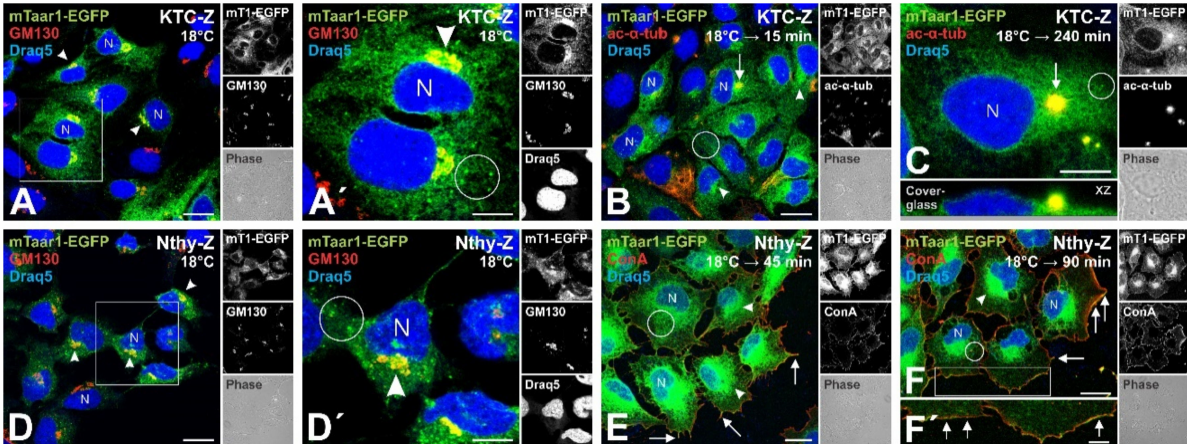
Figure 5. Pulse-chase experiment shows Taar1-EGFP transport along the secretory pathway to procilia of KTC-Z cells. ( A , A’ , D , D’ ) mTaar1-EGFP is localized in the Golgi (arrowheads) in KTC-Z and Nthy-Z cells directly following incubation at 18 ◦ C. Fixed cells were labeled with antibodies against the cis-Golgi marker GM130 (red). The boxed areas in A and D are magnified in A’ and D’ , respectively. The presence of mTaar1-EGFP (green) in the Golgi of both KTC-Z ( A , A’ ) and Nthy-Z ( D , D’ ) cells is evident from its co-localization (yellow) with GM130. mTaar1-EGFP is also seen distributed in a reticular pattern and as puncta (circles), which may represent ER-Golgi intermediate compartments or ER-exit sites. ( B , C ) KTC-Z cells were fixed 15 min and 4 h past shift from 18 ◦ C to 37 ◦ C, and immunolabeled with acetylated- α -tubulin. The presence of mTaar1-EGFP (green) on the procilia of KTC-Z cells (arrows) is evident from its co-localization (yellow) with acetylated- α -tubulin (red). Note that procilia are present only above the nuclei and are therefore not detectable in all cells of a given nuclear-near medial focal plane ( B ). In ( C ), a side-view of the same cell is provided as inset (bottom panel), demonstrating the spherical extension representing the procilium (arrow). ( E , F , F’ ) mTaar1-EGFP (green) co-localizes with ConA (red) on the surface of Nthy-Z cells (arrows) at 45 min ( E ) and 1.5 h ( F ) past shift from 18 ◦ C to 37 ◦ C. In ( F’ ), a magnified view of the boxed area in ( F ) is shown. ( A – F ) Single channel fluorescence micrographs are provided in the right panels, top to bottom: mTaar1-EGFP, GM130 or acetylated- α -tubulin or ConA, as indicated, and corresponding phase contrast. Draq5™ was used as nuclear counter-stain (blue). Scale bars in ( A , B , D , E , F ) represent 20 µ m, and in ( A’ , C , D’ , F’ ) 10 µ